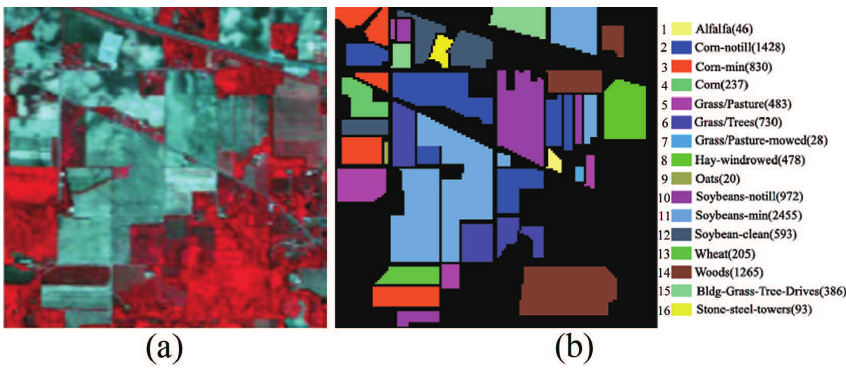
Figure 5. Indian Pines hyperspectral image. ( a ) HSI in false color; ( b ) Ground